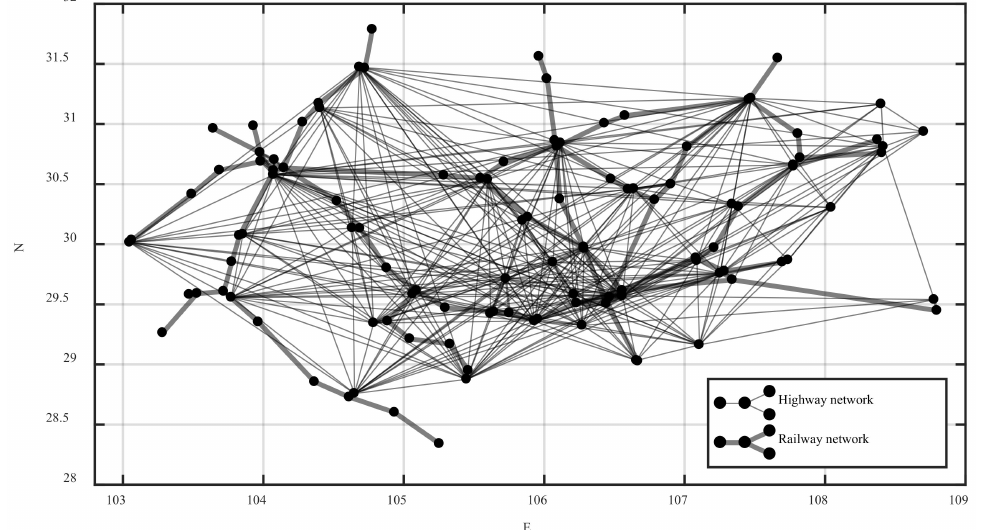
Figure 6. The integrated passenger transport network of the Chengdu–Chongqing urban agglomeration.